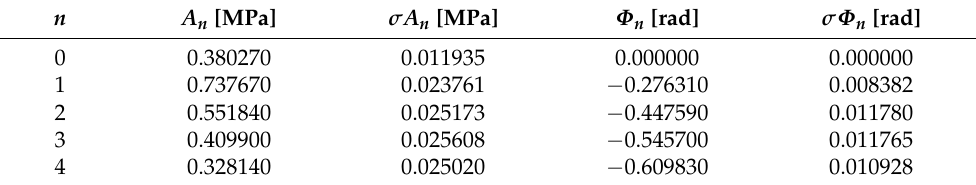
Table A2. The values of coefficients A n and Φ n and standard deviations σ A n and σΦ n